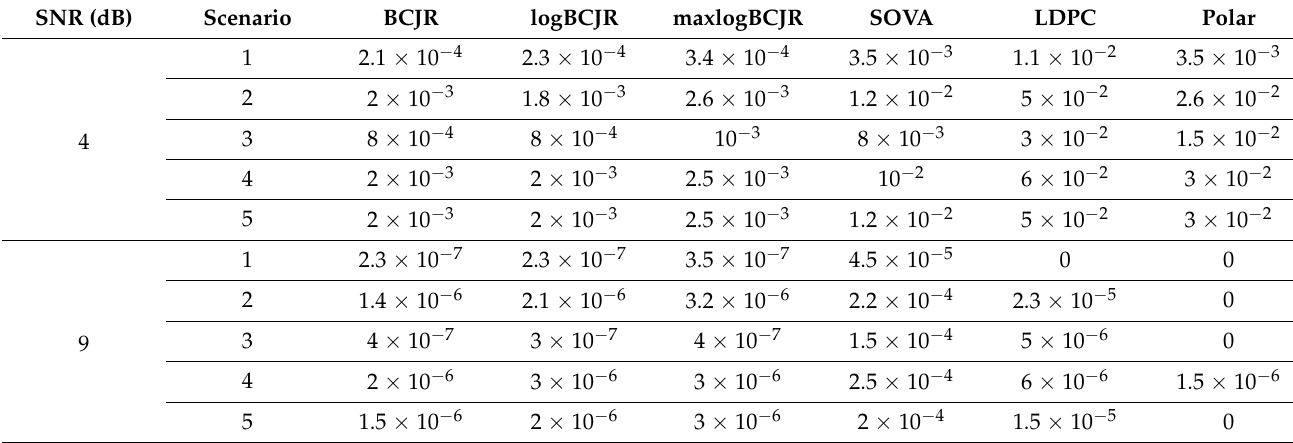
Table 8. BER values for 4 and 9 dB SNR, 128-bit